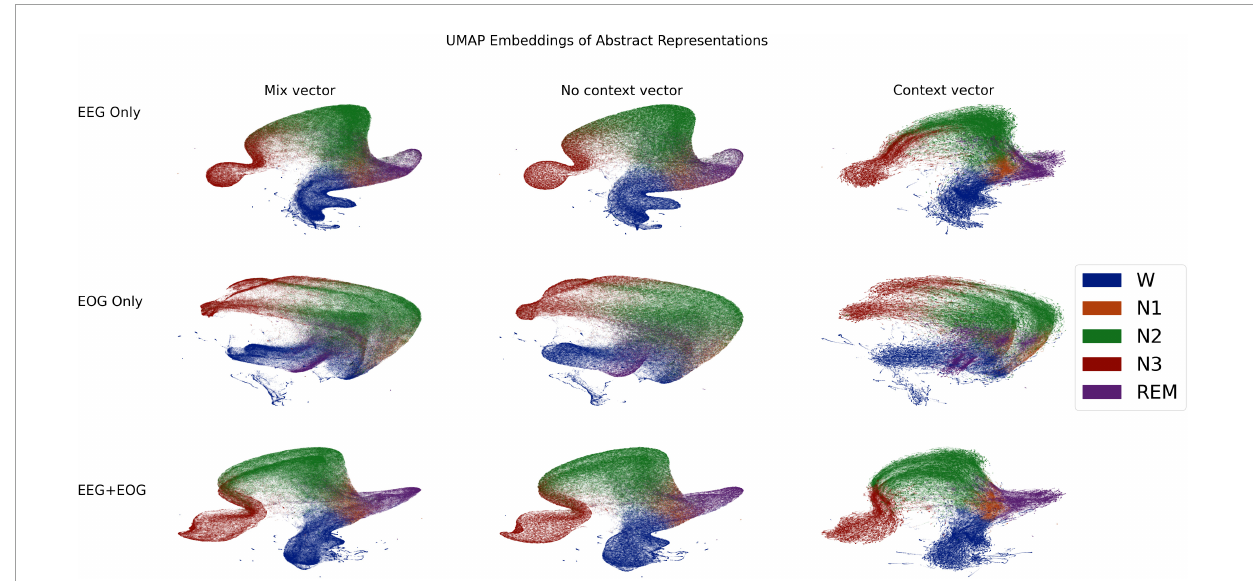
FIGURE9 2 dimensional uniform manifold approximation and projection (UMAP) (Sainburg et al., 2021) embeddings of the vectors produced by the mixing/compression networks (left column) , the context-free inference (middle column) , and context-aware networks (right column) of the classifier. Each dot represents an embedding of a vector calculated from a single, 30 s epoch of a PSG from the testing set. Dots are color-coded by the sleep stage which was later inferred from that vector. See section Network Interpretability for